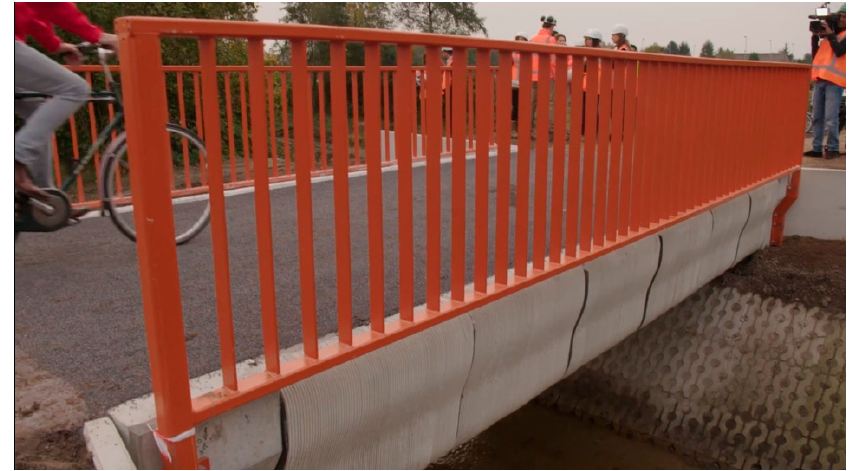
Figure 10. 3D printed bicycle bridge developed by Eindhoven University of Technology (Reproduced from [52]).